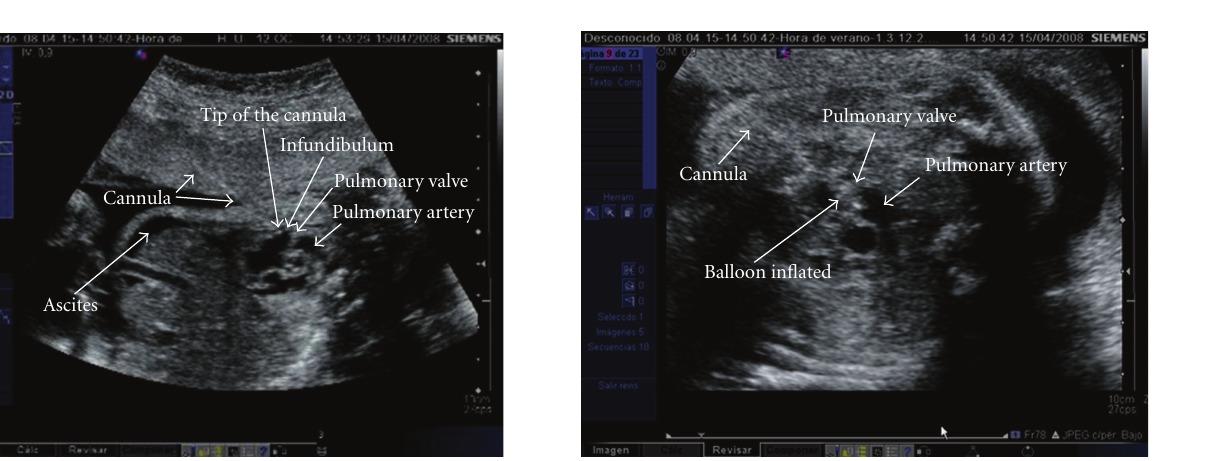
Figure 1: Cannula course during fetal cardiac intervention for pul- monary valvuloplasty, entering the right ventricle at the infundib- ulum, in the longitudinal view, with the cannula course parallel to the RV outflow tract.